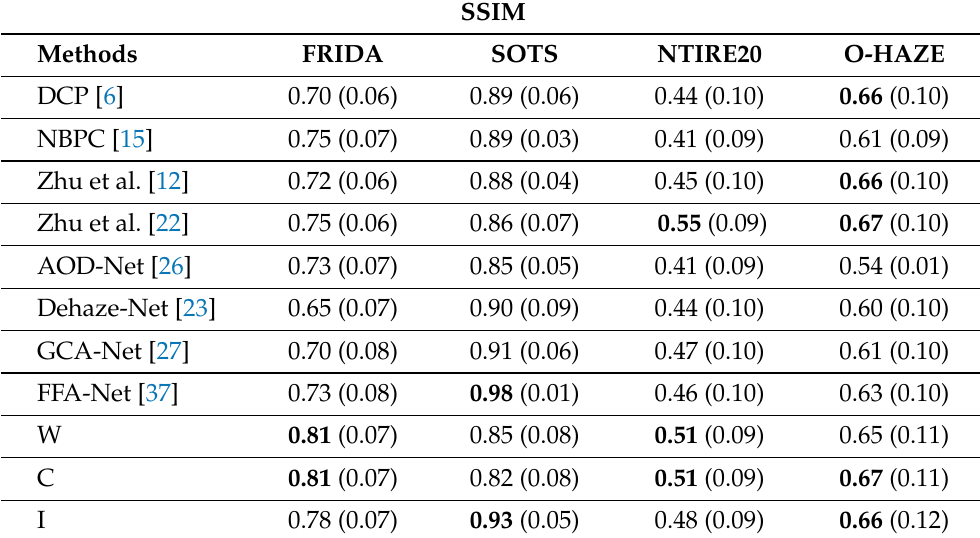
Table 3. Comparison of the SSIM index on four datasets: fifty images from the FRIDA and the SOTS datasets, forty-five images from the NTIRE20 and the O-HAZE datasets. W corresponds to our main algorithm assuming white fog, C is the color version (see Section 3.6), and I the interpolated version (see Section 3.5). The best results are in